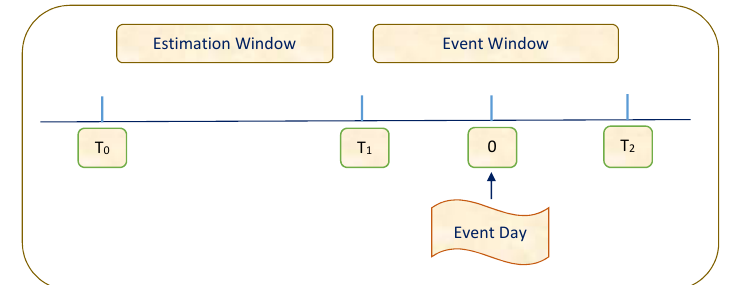
Fig. 1: Estimation window covers 160 trading days, 5 to 10 days before event day is considered as anticipation period and 10 days after event day as adjustment period.